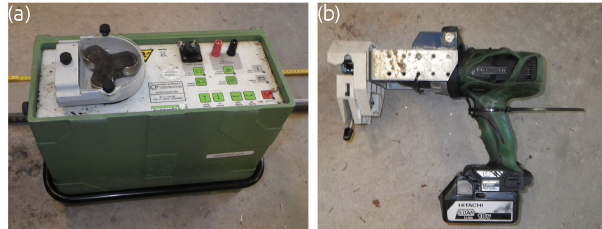
Figure F1. Photo of a peristaltic pump (a) . Peristaltic pump mounted on a drill (b) used for purging the wells.